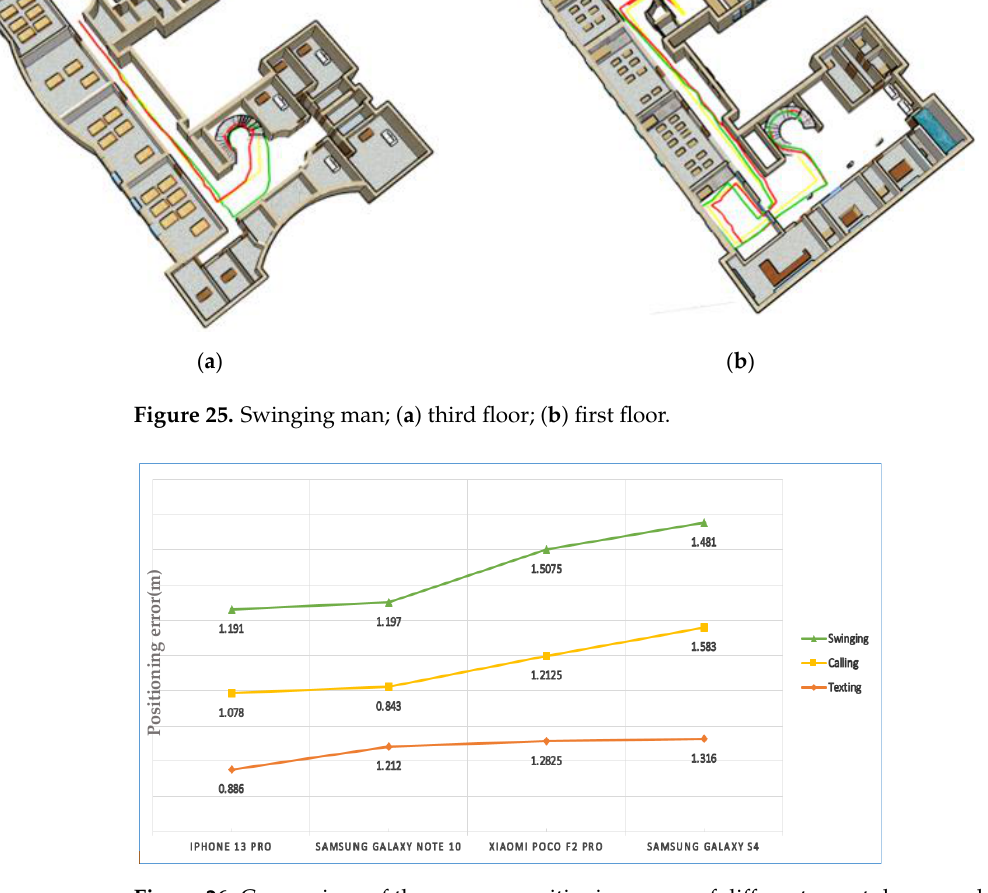
Figure 26. Comparison of the average positioning errors of different smartphone models.